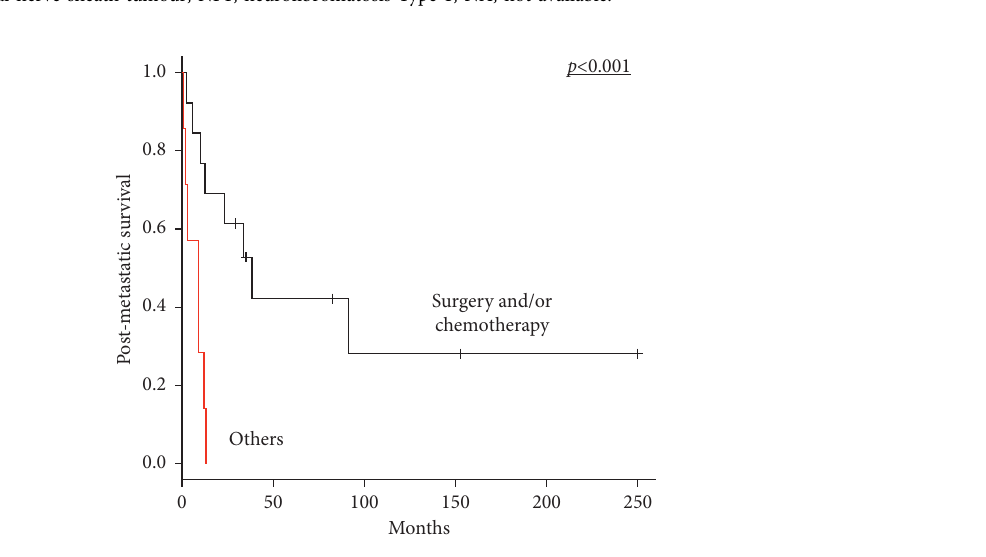
Figure 3: Kaplan–Meier survival curve of postmetastatic survival according to surgery and/or chemotherapy for metastatic lesions in 20 patients with metastatic MPNST who underwent surgery for their primary tumour (presence versus absence of surgery and/or chemo- therapy for metastatic lesions). MPNST, malignant peripheral nerve sheath